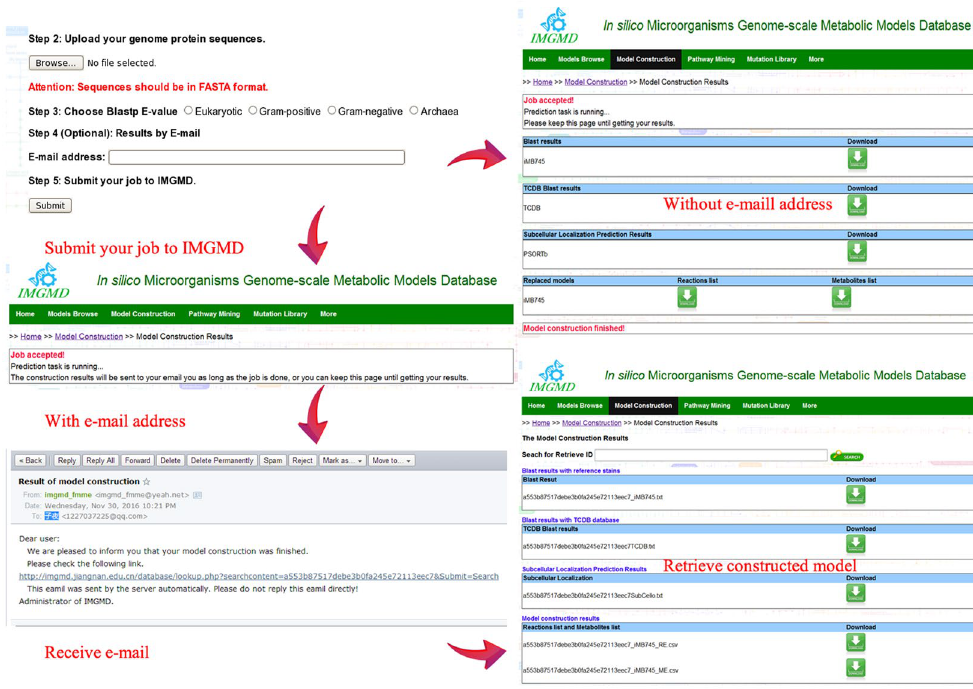
Figure 3. Flow chart for model construction in the IMGMD database.